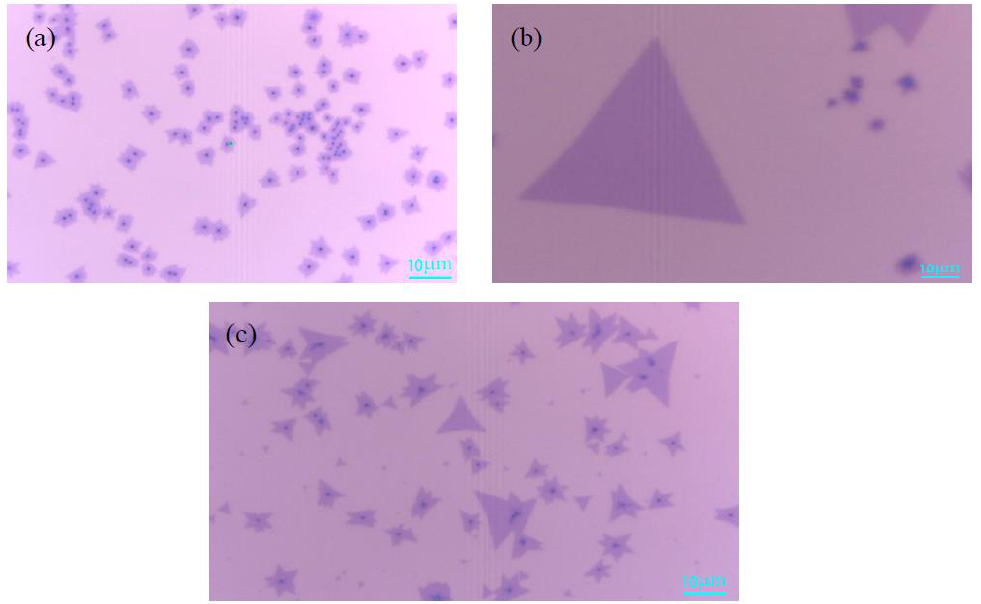
Figure 5. Optical microscope images of MoS 2 with different argon flow rate ( a ) 20 sccm; ( b ) 35 sccm; ( c ) 50 sccm. Scale bar: 10 μm .